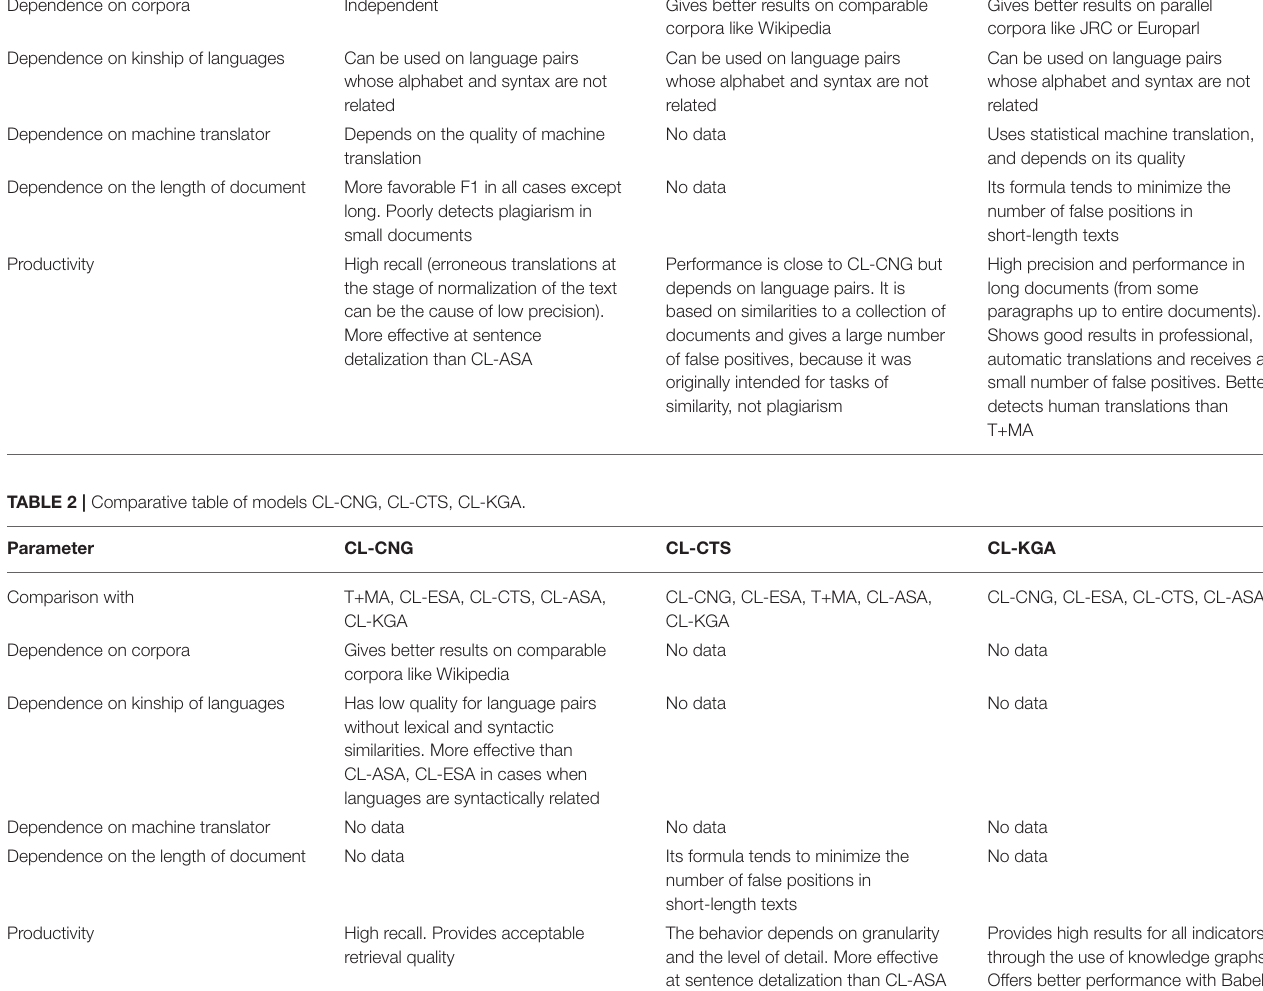
Table 4 introduces our comparative results of the approaches used in the articles for the Russian-English pair. Precision, recall, and F1 characteristics are also represented in Figures 2 – 4